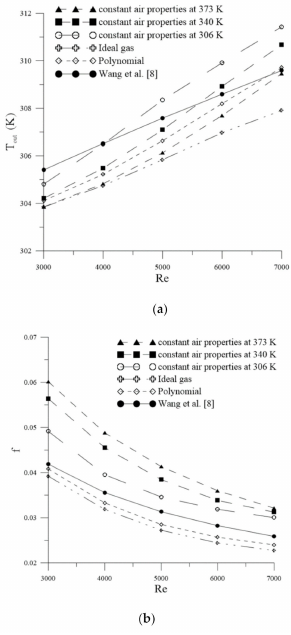
Figure 7. The comparisons of ( a ) T out and ( b ) f for PTHE-Z with the corrected values [8] using five di ff erent physical properties of air.